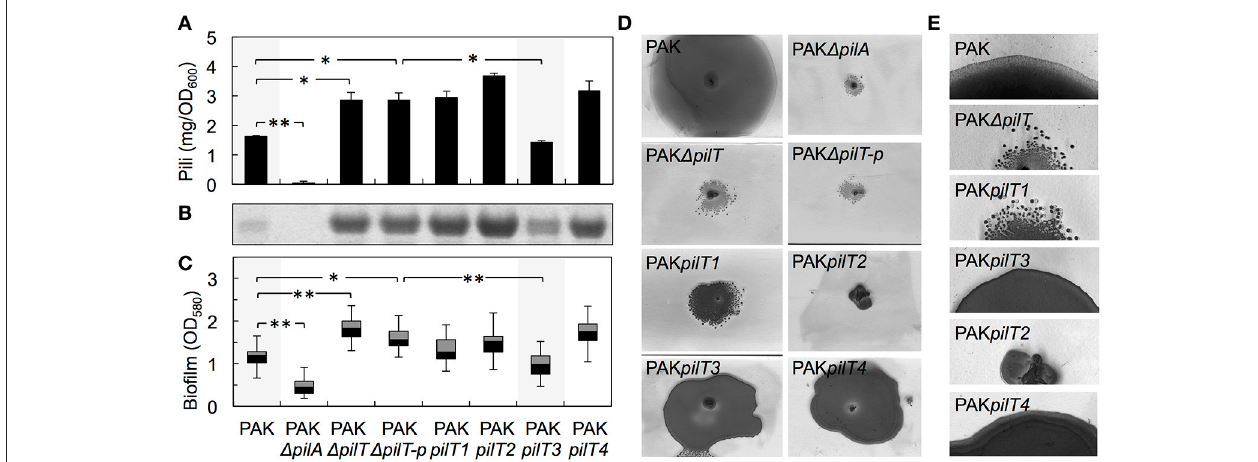
FIGURE 4 | Heterologous expression of G. sulfurreducens pilT genes in the hyperpiliated, non-twitching PAK 1 pilT mutant. (A–C) Restoration by pilT3 of WT levels of piliation [shown as purified pili protein (A) and Coomassie-stained pilin protein band after SDS-PAGE (B) ] and biofilm density (C) in the PAK 1 pilT strain. The pilin-deficient PAK 1 pilA and hyperpiliated PAK 1 pilT -p strain (carrying the empty pMMB67EH vector) are shown as controls. Data are average and standard deviation of pili protein (mg/OD 600 ) purified from three biological replicates (A) and median and first and third quartiles of biofilm biomass from six biological replicates, each containing 5–8 technical replicates (C) . Statistically significant changes in pili content (A) and biofilm biomass (C) were determined in two-tailed pairwise comparisons with the WT or PAK 1 pilT -p strains using the t -test function of the Microsoft Excel software (* p < 0.01, ** p < 0.001). (D) Twitching motility slide assays showing the Coomassie-stained zones of surface expansion in the wild-type PAK, which are absent in the pilin-deficient PAK 1 pilA and non-twitching PAK 1 pilT and PAK 1 pilT -p strains. Expression of pilT3 and pilT4 (PAK pilT3 and PAK pilT4 strains) restored the twitching motility deficiency of the PAK 1 pilT strain. (E) Micrographs showing the zones of expansion on the edge of PAK colonies shown in (D) .